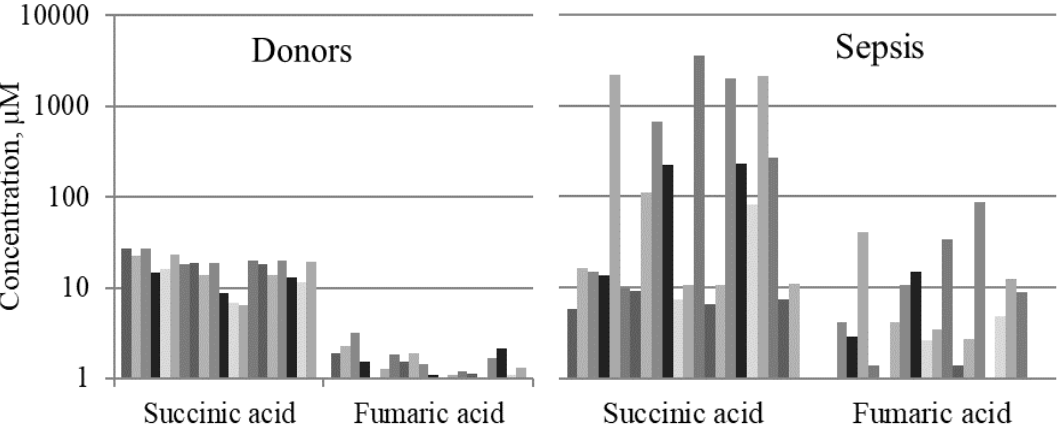
Figure 2. Concentrations of mitochondrial metabolites ( µ M) in the serum samples of healthy controls ( n = 20) and patients with late sepsis ( n = 22). Data is shown on a log scale with a base of 10.